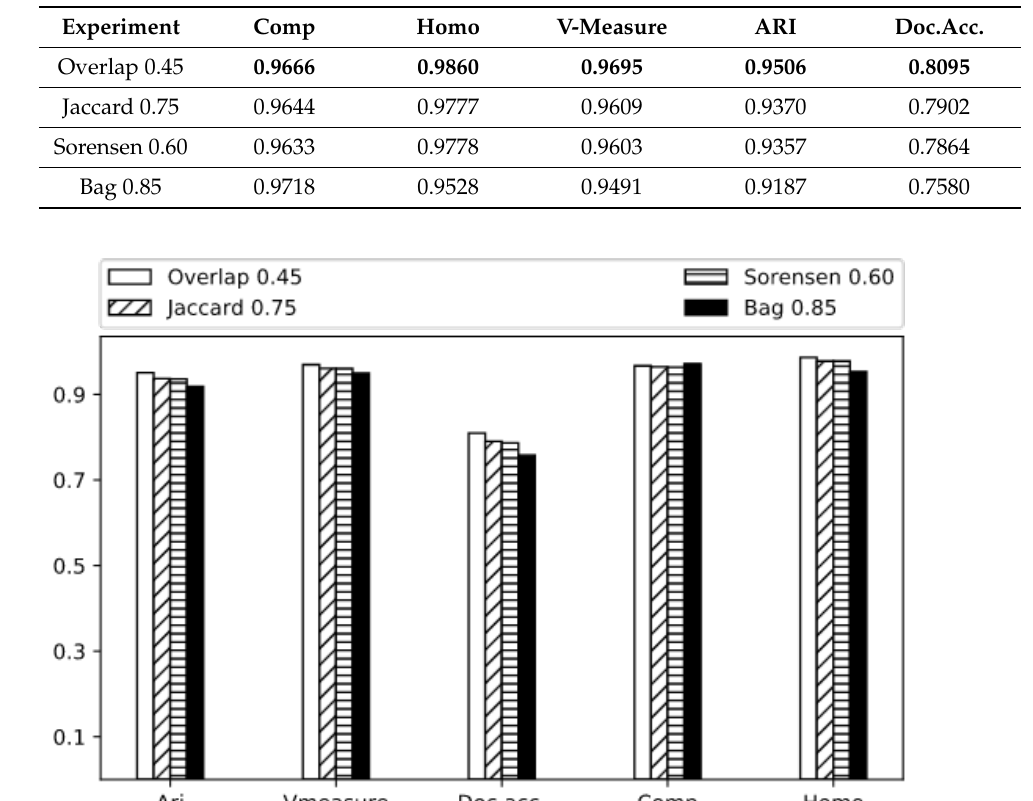
Table 4. Performance of our four top best experiments.